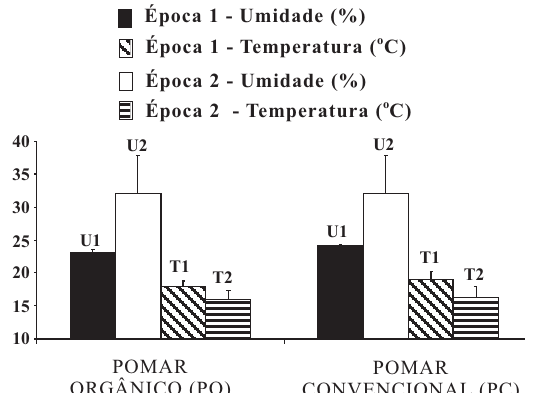
Figura 2. Umidade e temperatura do solo medidas no momento da coleta em pomares de maçãs nos sistemas de produção convencional e orgânico. Barras representam o erro-padrão (n =